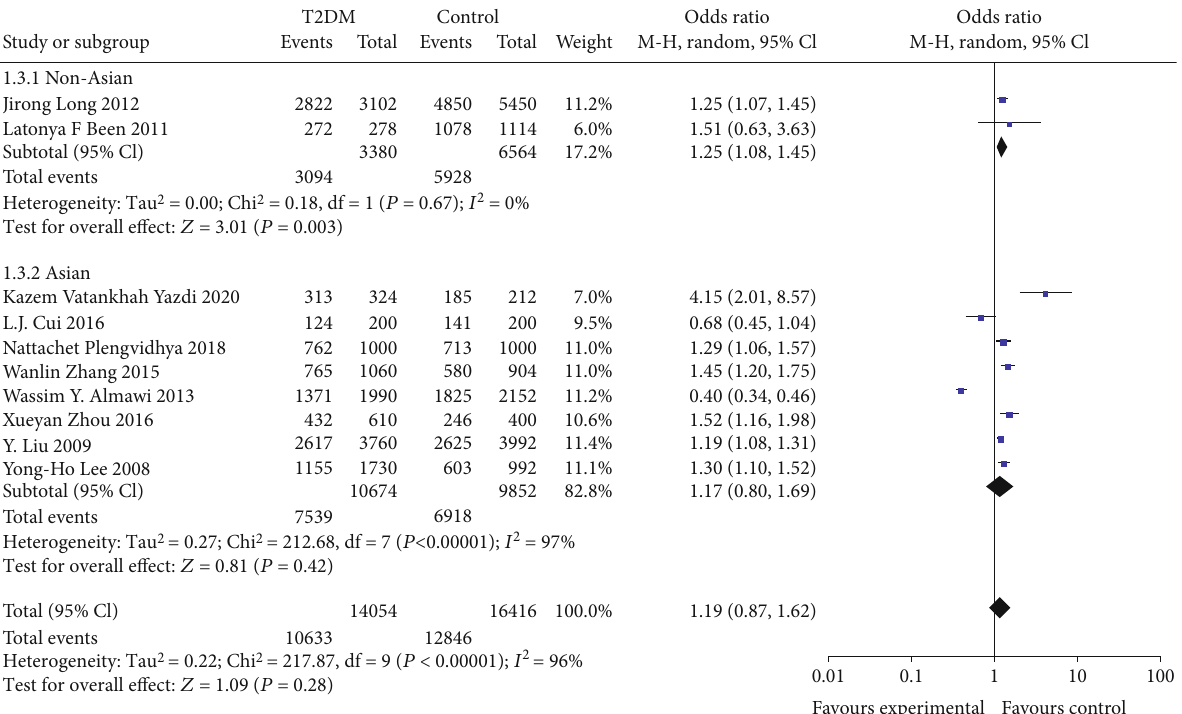
Study or subgroup